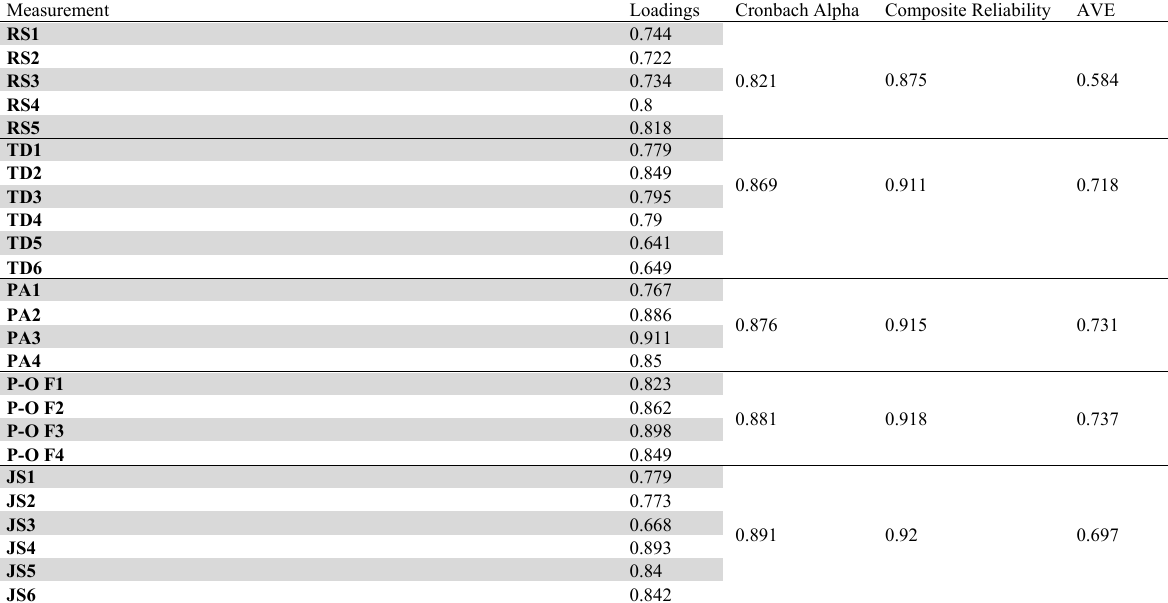
Measurement model